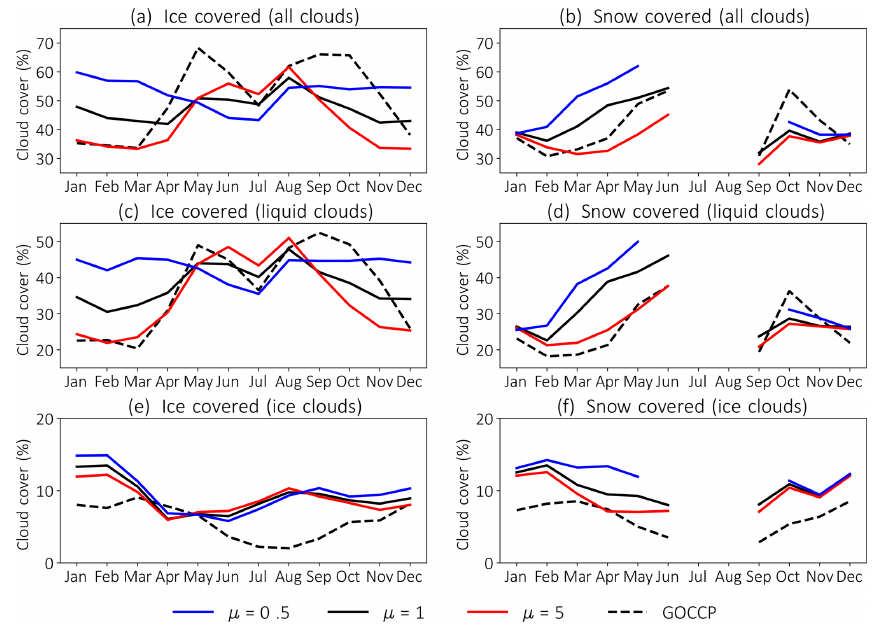
Figure 7. Northern Hemisphere low-level cloud cover from ECHAM6 + COSP over sea-ice-covered (a, c, e) and snow-covered (b, d, f) surfaces for different strengths of surface mixing for all clouds (a, b) , liquid clouds (c, d) , and ice clouds (e, f) . The respective GOCCP cloud cover is shown for